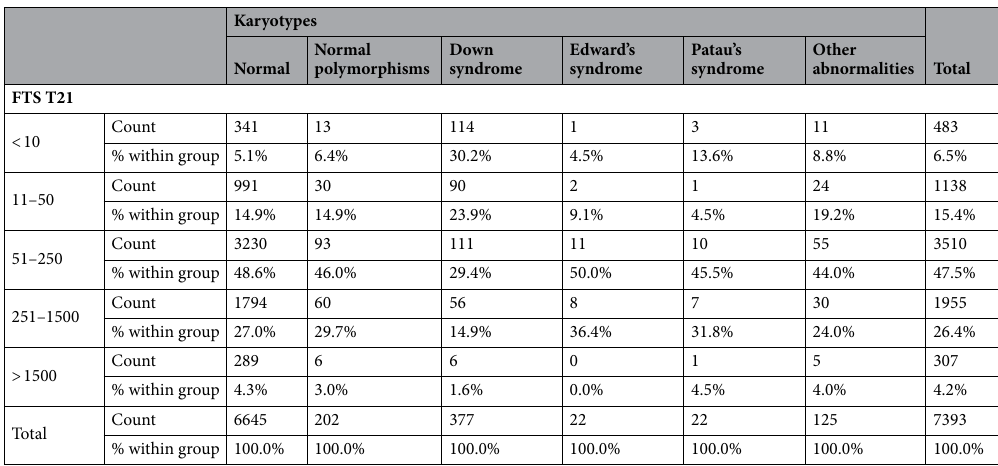
Table 10. Distribution of chromosomal abnormalities within different groups based on the risk calculated in first trimester screening (FTS) for Down